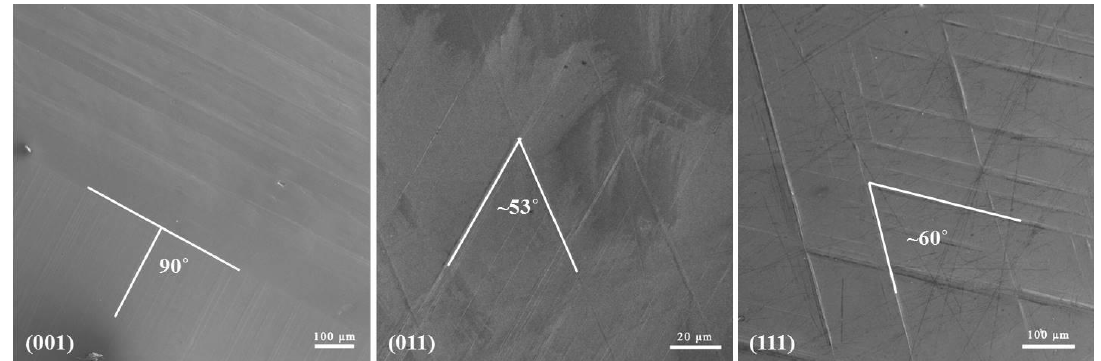
Figure 1. Optical micrographs of the surface morphology of the cryo-quenched Fe-15Cr-15Ni single-crystal alloy after He + irradiation to 2 × 10 17 ions cm −2 at 500 °C (irradiated surfaces are well polished prior to He +